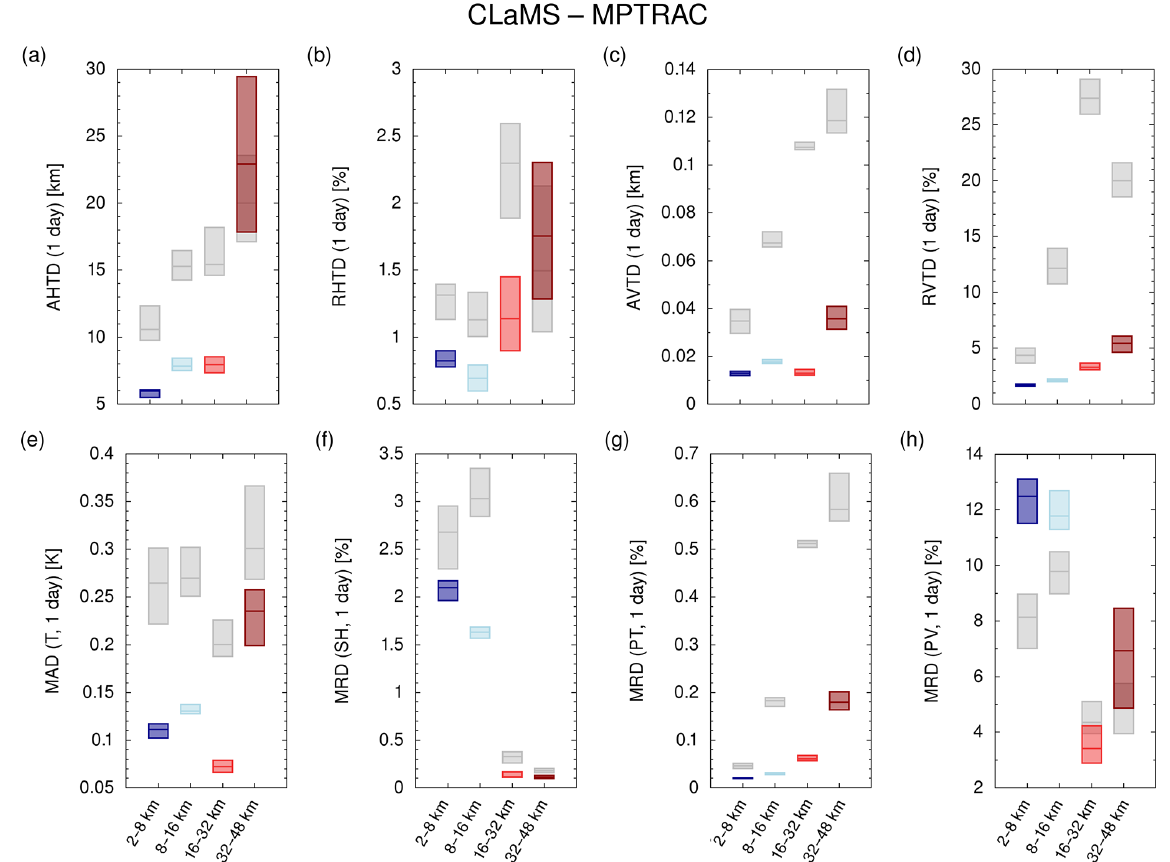
Figure 16. Global transport deviations (a, b, c, d) as well as differences in meteorological variables and dynamical tracers (e, f, g, h) of 1-day forward trajectories calculated with ERA5 data and the CLaMS or MPTRAC model (blue and red bars). Deviations due to parameterized diffusion and subgrid-scale wind fluctuations imposed on ERA5 trajectories are shown for reference (light gray